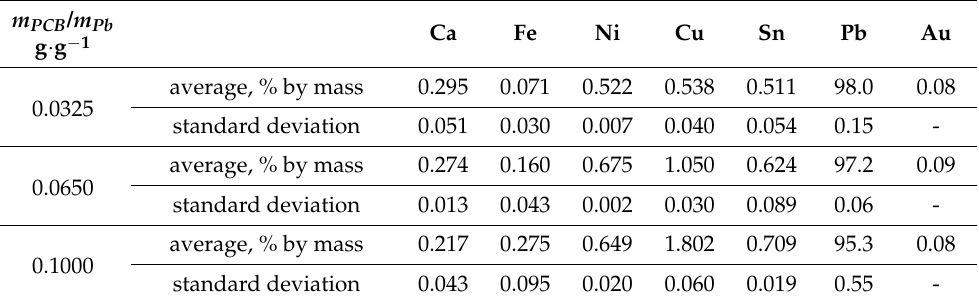
Table 5. Chemical compositions of the lead ingots after melting with PCB pyrolyzate “B3”, averages and standard deviation of 3 analyses.